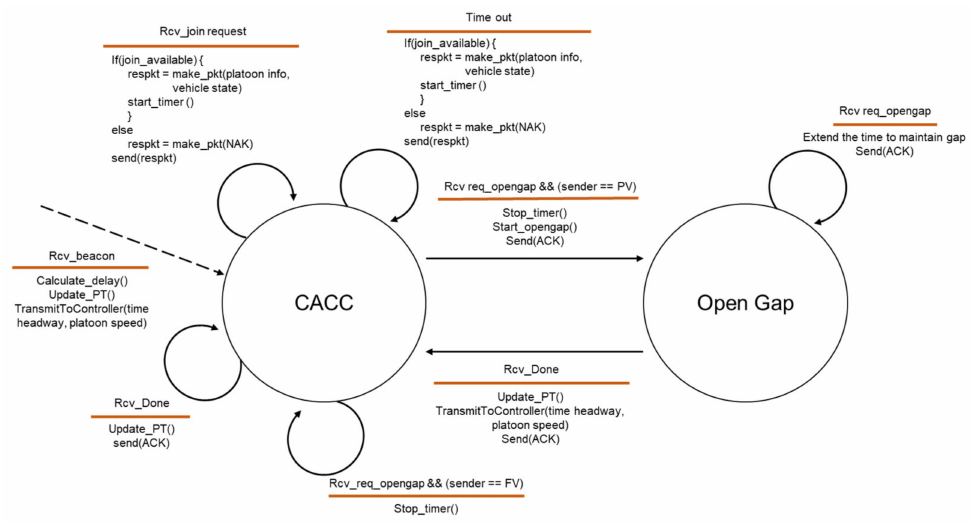
Figure 3. State machine of platoon member vehicle.